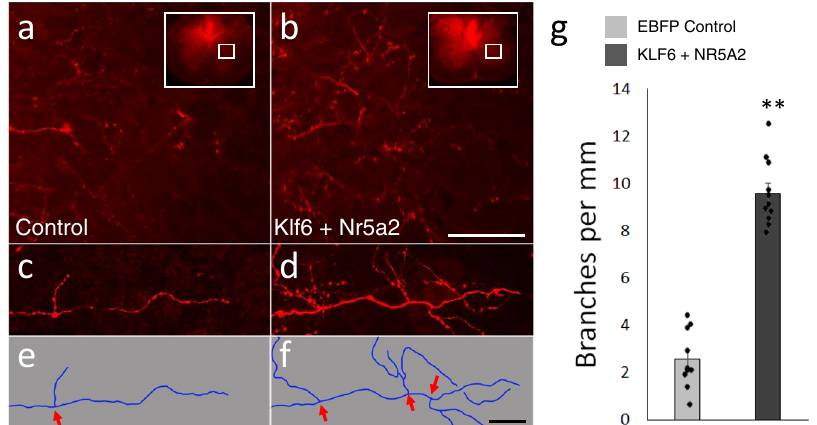
Fig. 5 Combined Klf6/Nr5a2 treatment increases the frequency of CST axon branching. a , b CST axons transduced with control ( a ) or Klf6 and Nr5a2 ( b ), which have extended across the midline into contralateral cervical spinal cord. c – f At higher magni fi cation, instances of branching can be identi fi ed (arrows). g Animals that received combined Klf6 and Nr5a2 showed a signi fi cant increase in the frequency of branch formation above control animals ( p = 1.89 − 10 , two-tailed t -test). A minimum of 5 mm of growth, from three separate sections, was quanti fi ed for each of ten animals in both groups. Scale bars are 100 µ m ( a , b ) and 20 µ m ( c – f ). Dots in g represent values in single animals. Source data are provided as a Source data fi le.